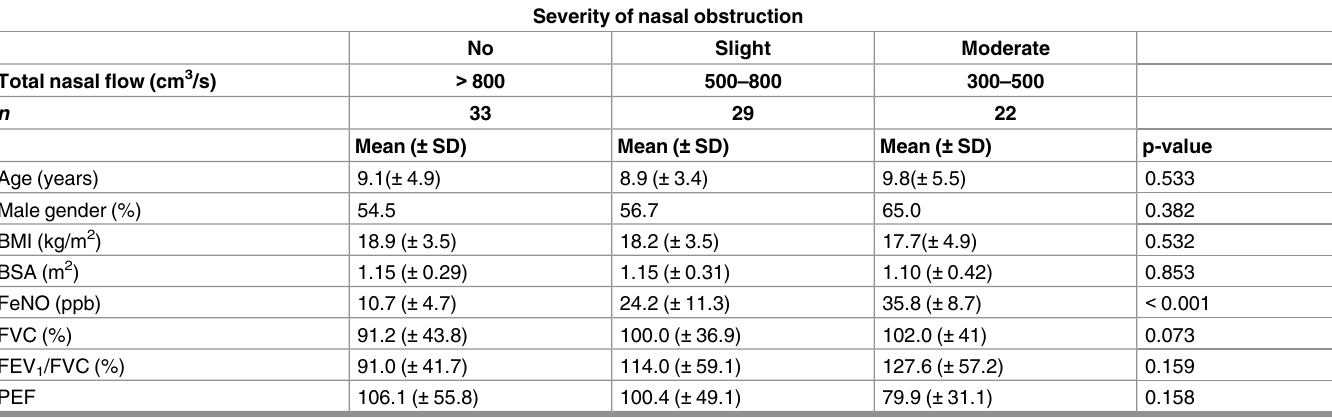
Table 2. Spirometric and rhinomanometric measurements in patients with differing severities of nasal